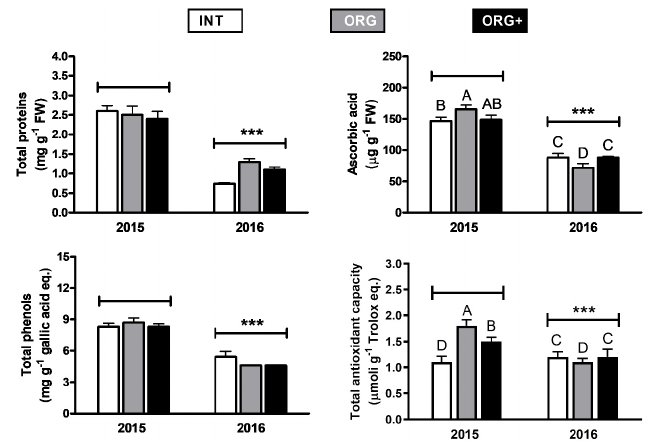
Figure 6. Total proteins, ascorbic acid, total phenols, and total antioxidant activity of eggplant cultivated according to three different cropping system: integrated (INT), organic farming (ORG), and organic no-tillage (ORG + ) in a two-year experiment. Each value is the mean ± SD of three replicates. Means keyed with the same capital letter are not significantly different for p = 0.05 following two-way ANOVA using production year (2015–2016) and the three different cropping systems (INT, ORG, and ORG + ) as the variability factors. When the F ratio in the two-way ANOVA interaction was not found significant, data were analyzed by one-way ANOVA using year of cultivation or cultivation systems (considering the average of two years of production) as the variability factor. The presence of asterisks denotes significant differences for p < 0.05 following one-way ANOVA using production year as the variability factor (*** p < 0.001), whilst the presence of different lowercase letters denotes significant differences for p < ‘0.05 following one-way ANOVA using cropping systems as the variability